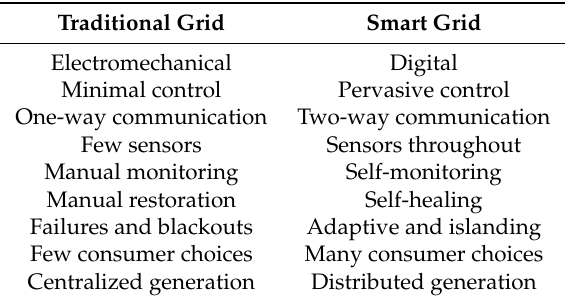
Table 4. Highlights of traditional and smart grids